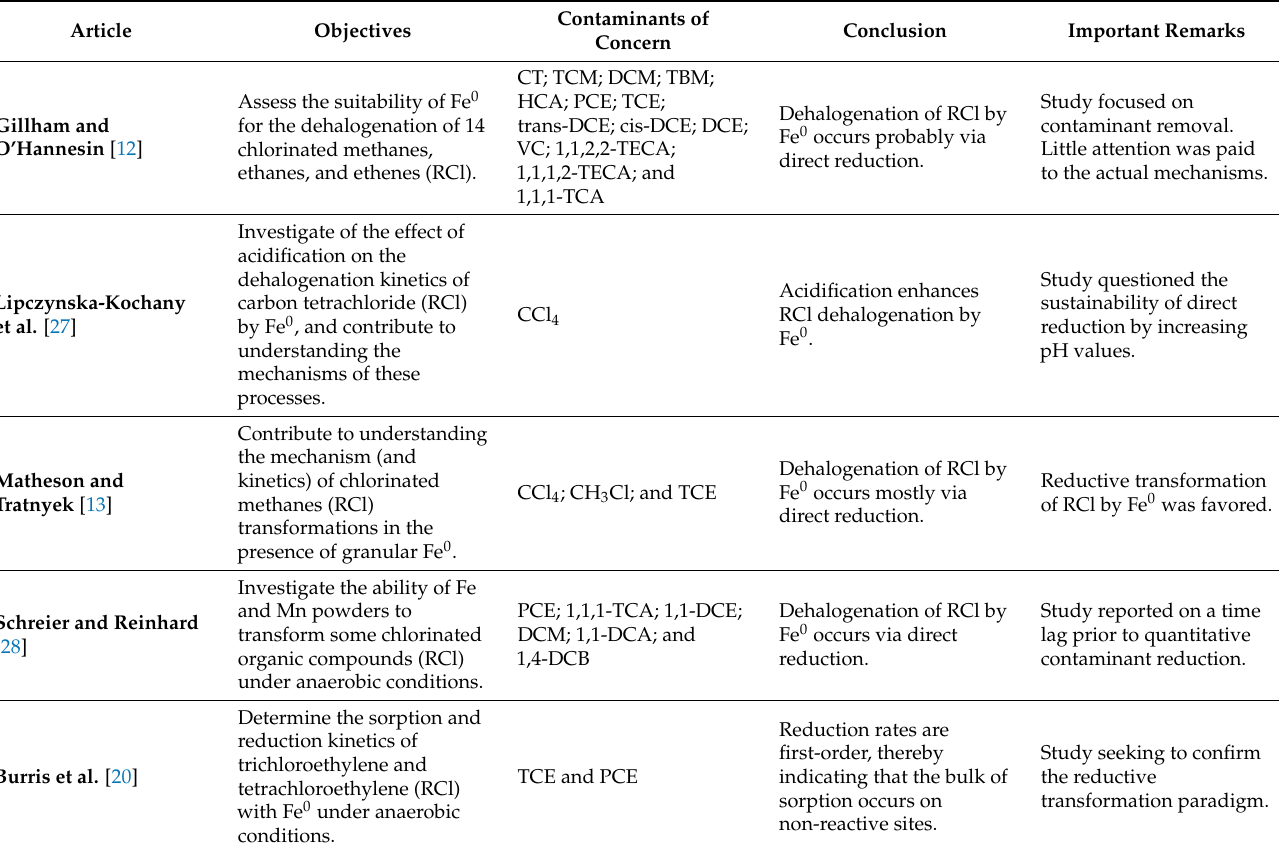
Table 1. Outline of relevant arguments given to justify the process of contaminant removal using Fe 0 /H 2 O systems up to the “broad consensus” in 1998